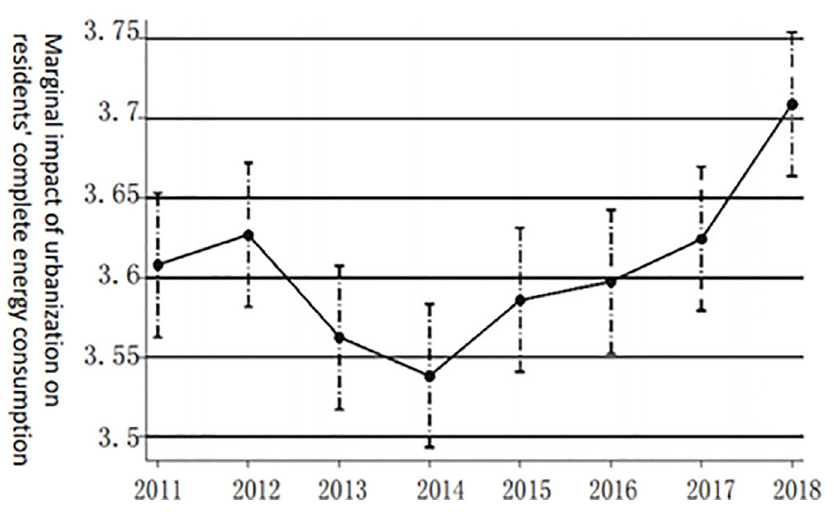
Fig 1. Dynamic effect of urbanization on the marginal impact of complete energy consumption of the